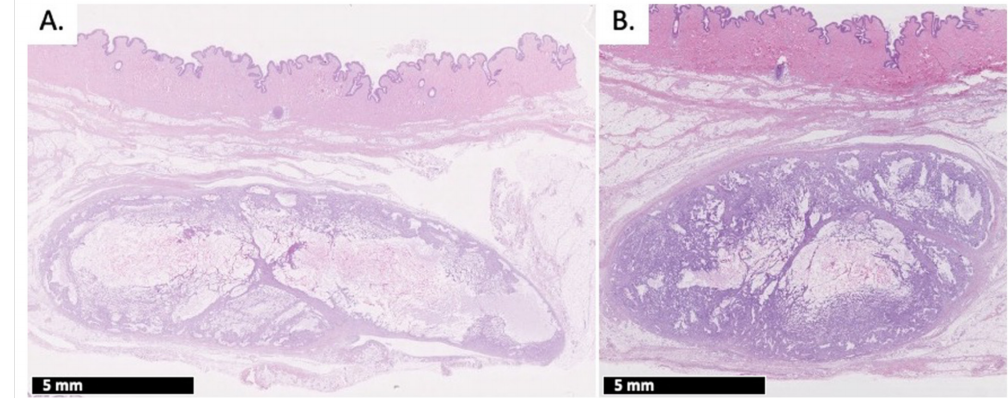
Figure 5. H&E histopathology of 1 mL test item depots at 240 h, administered at ( A ) slow and ( B ) fast injection flow rate. Full histopathology grading is available in Table